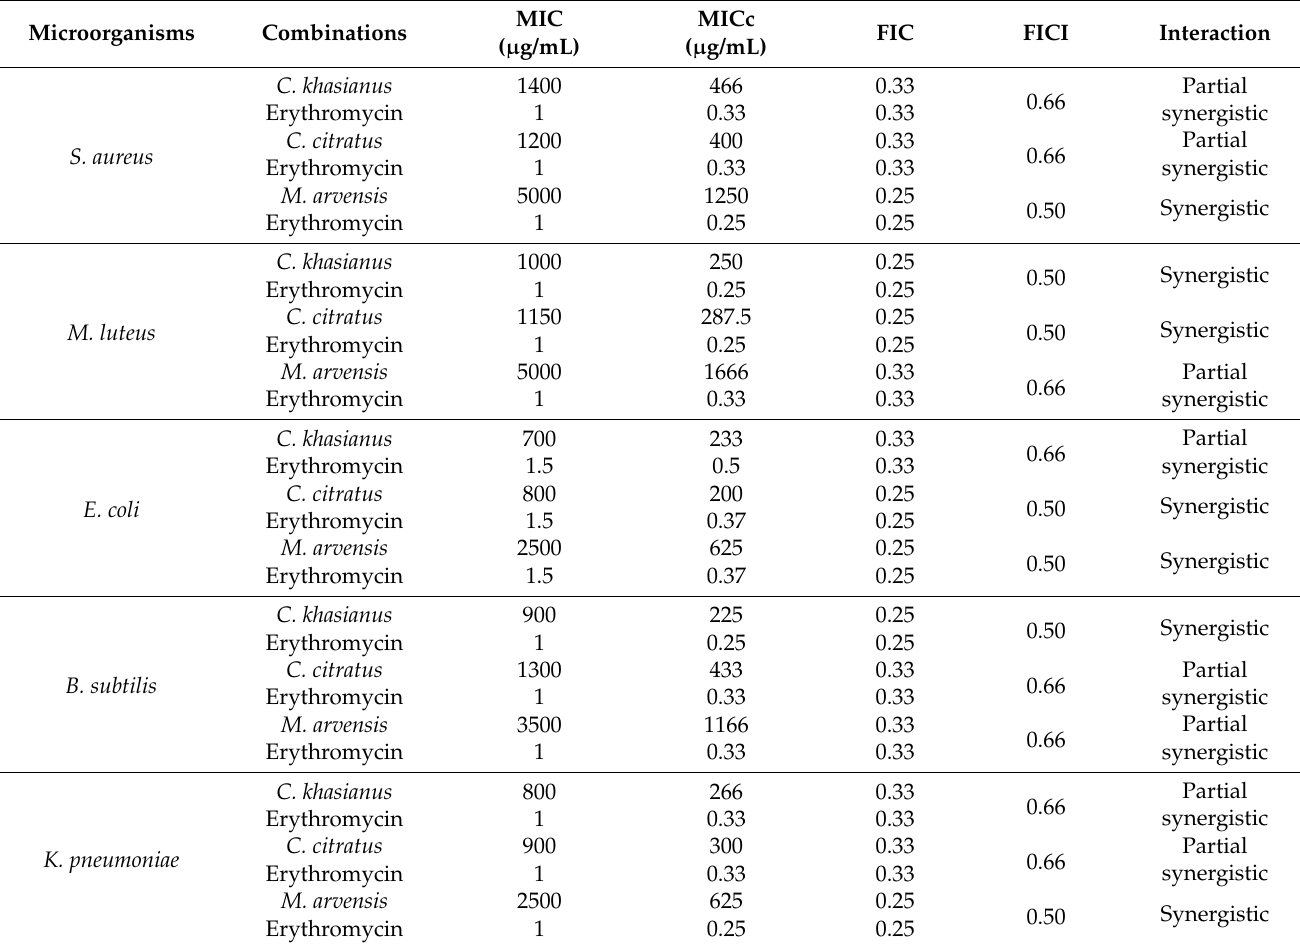
Table 5. Effect of combinations between essential oils and erythromycin. Microorganisms